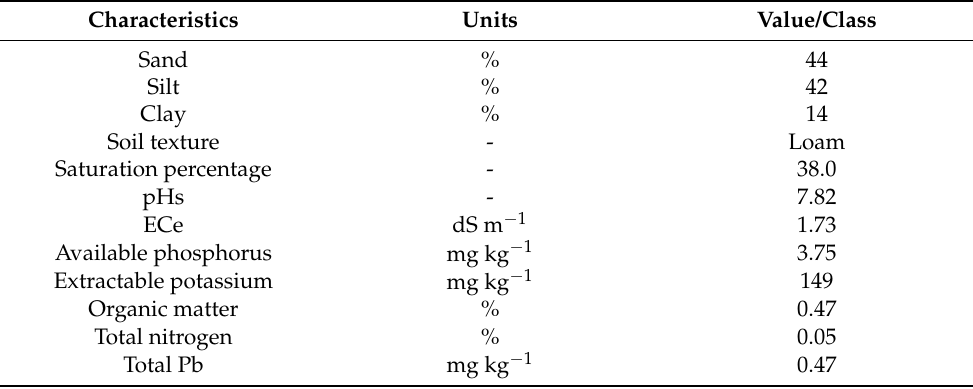
Table 1. Physical and chemical characteristics of the soil used for pot